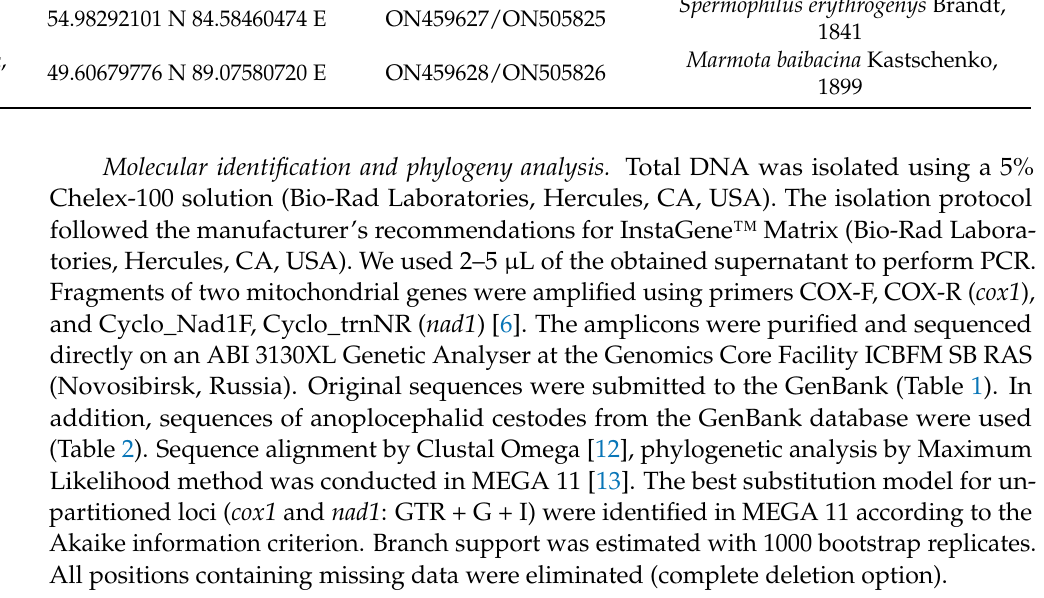
Akaike information criterion. Branch support was estimated with 1000 bootstrap replicates.